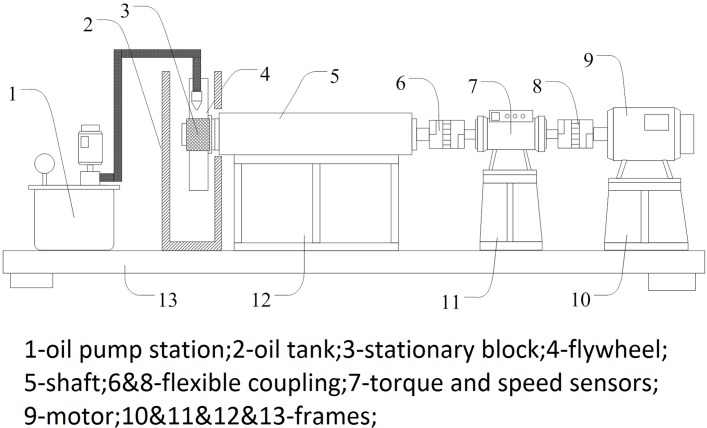
Schematic diagram of the apparatus.